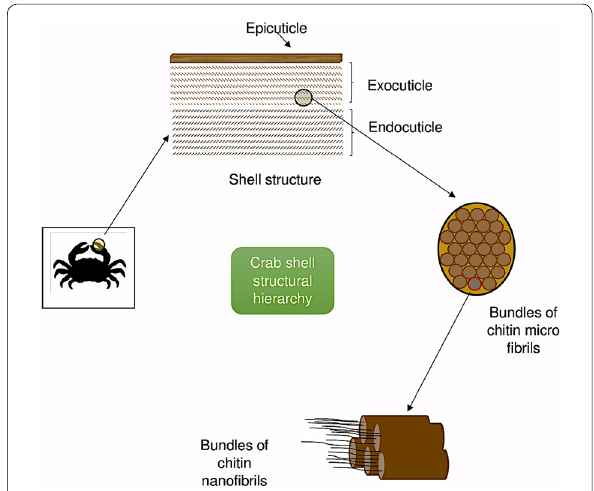
Fig. 2 Hierarchical arrangements of chitin fibers in crab